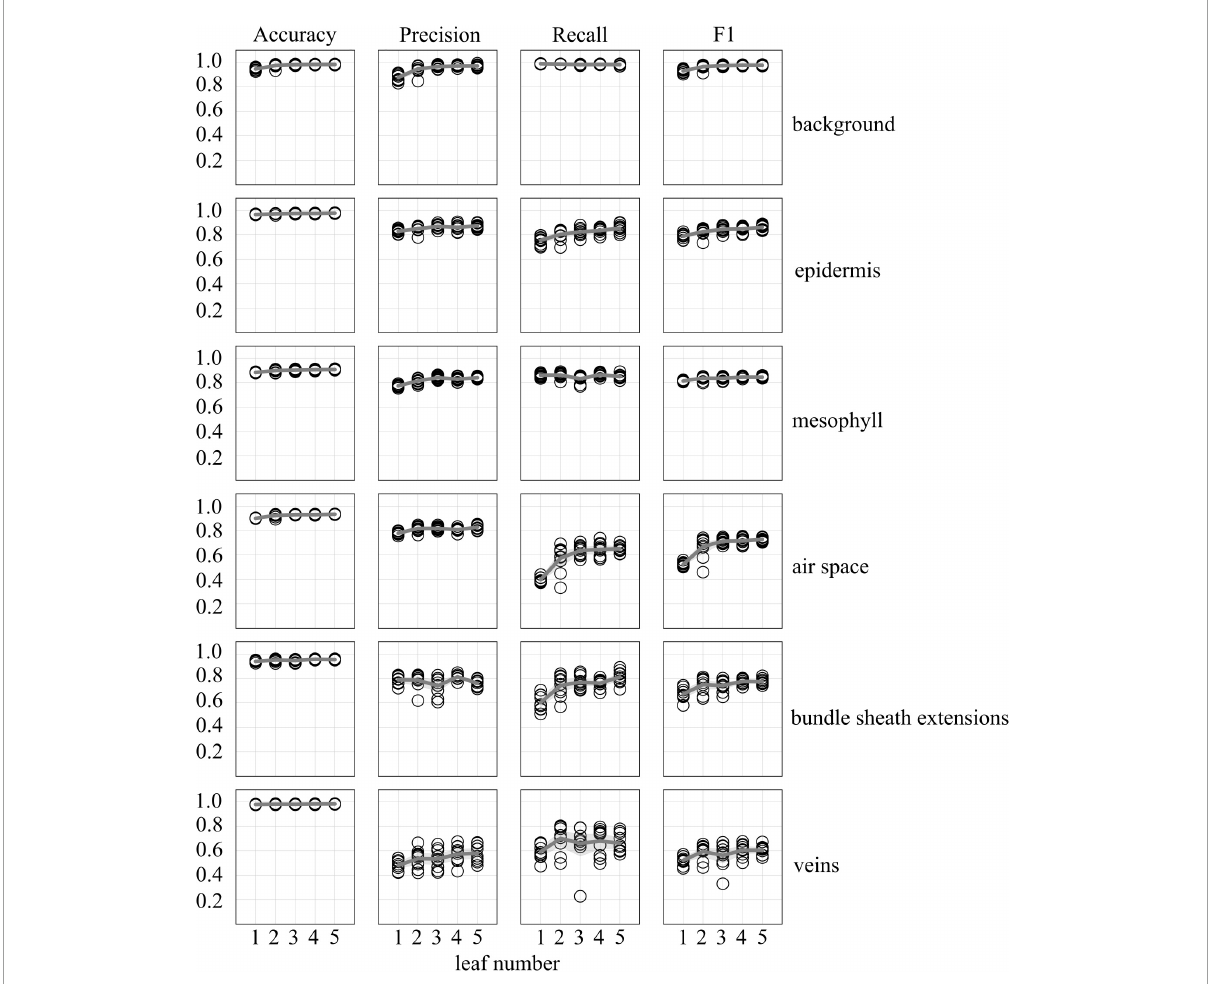
FIGURE2 Accuracy, precision, recall, and F1 scores as a function of uniquely annotated leaf number (5 annotated images per leaf) used to predict tissue classes in X-ray µ CT images from an independent leaf on which the models were not trained or validated. Circles represent unique predictions from 10 uniquely generated models per leaf number; dark gray lines represent the mean value of the 10 models while thick light gray lines represent the 95% confidence interval of the